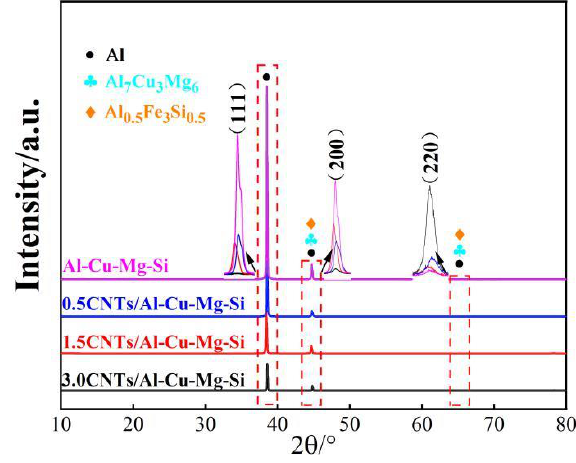
Figure 4. XRD patterns of CNTs/Al-Cu-Mg-Si composites. Table 2. XRD data showing the intensity variation of the identified peaks for Al phase in the CNTs/Al-Cu-Mg-Si composite.